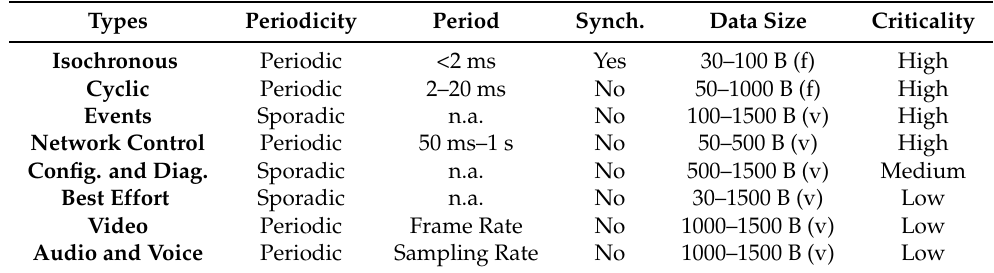
Table 2. Traffic types [13] (f: fixed, v: variable).